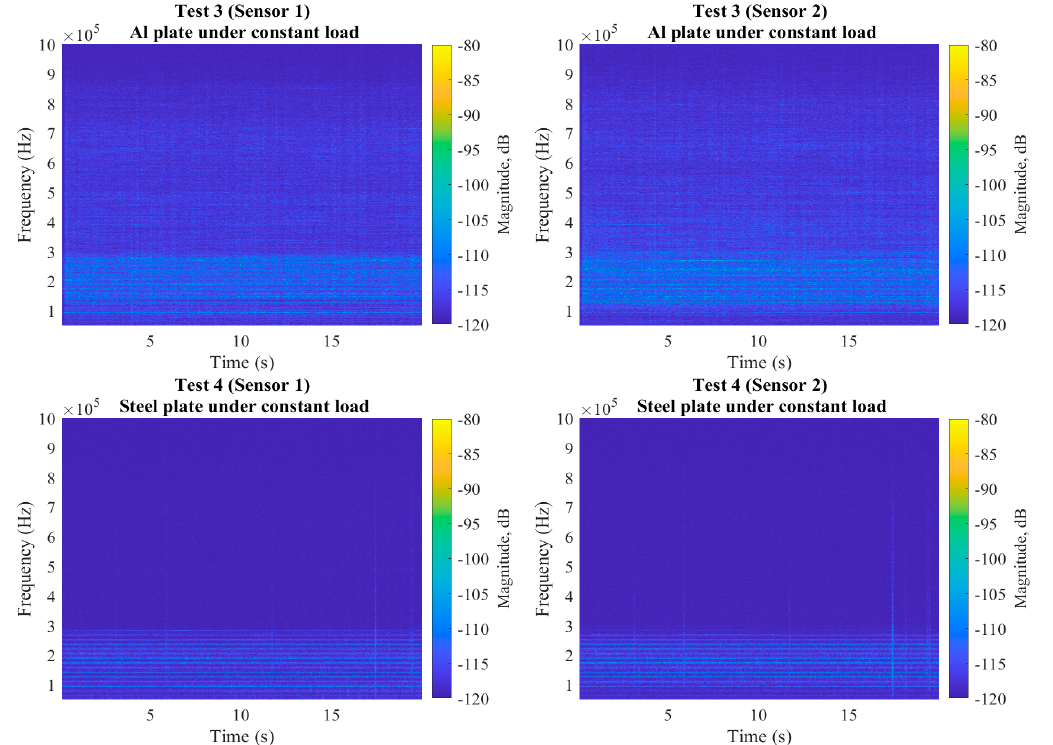
Figure 13. STFTs of tool steel indenter on tool steel sheet ( left ) and tool steel on Al sheet ( right ) sheet under constant load.